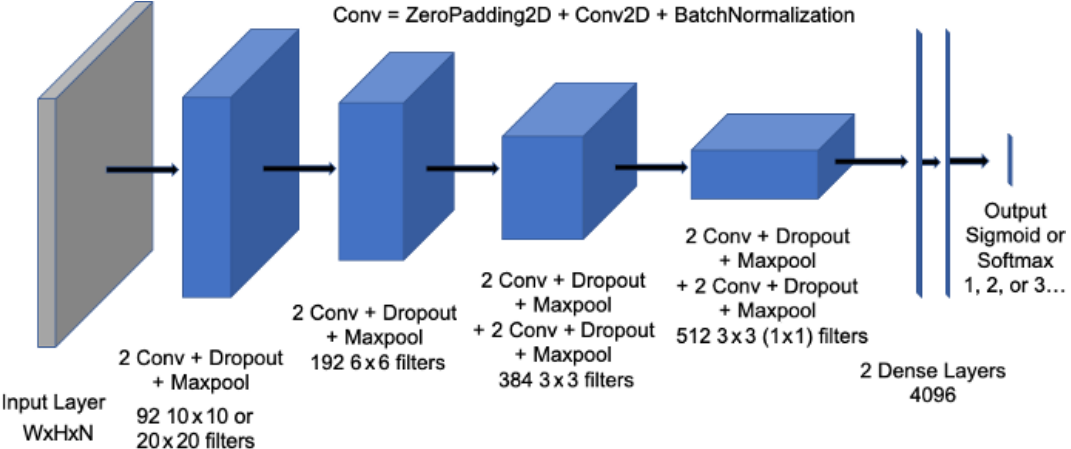
Figure 1. Architecture of the 12 convolutional plus 4 dense layers of HazeNet. Here “Conv” represents a unit containing zero padding and then a 2D convolutional layer, followed by a batch normalization layer. There is a flattened layer before the two dense layers. W stands for width, H stands for height, and N stands for the number of features of the input fields (i.e., 64, 96, and 16 for Beijing and 64, 64, and 16 for Shanghai.